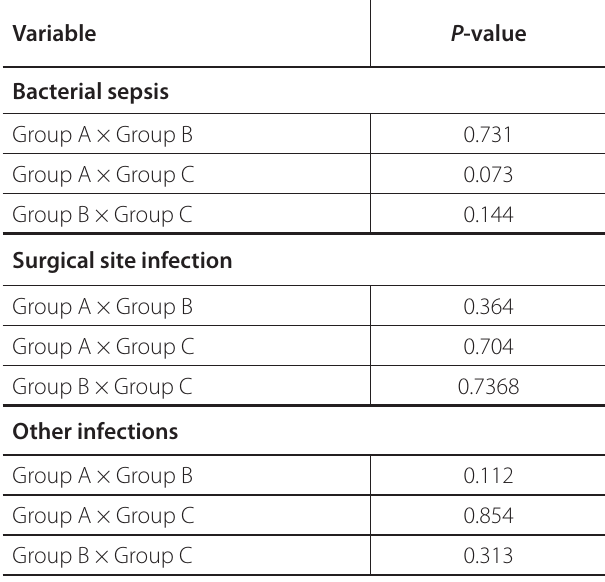
Table 7 . Comparative analysis of variables related to infection